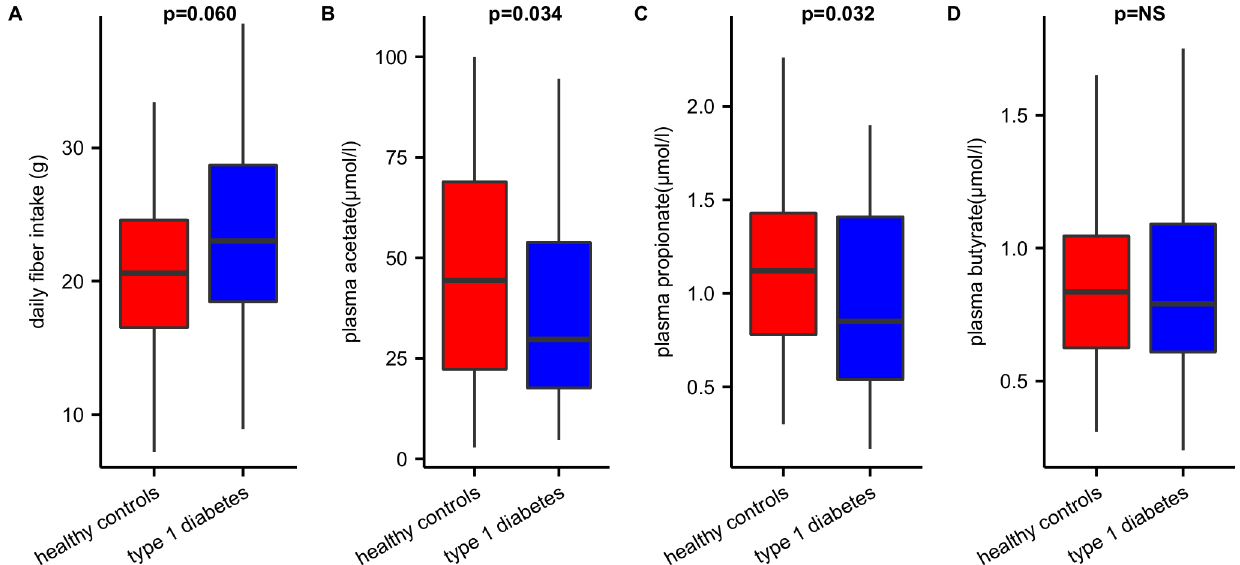
Fig 1. Plasma SCFA and dietary fiber intake. The figure shows that (A) despite higherfiber intake, we (B) found decreased plasma levels of acetate and (C) propionateand (D) similar levels of plasma butyrate in controls vs T1D subjects.